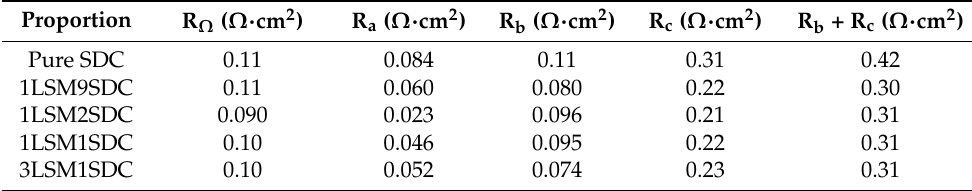
Figure 7. ( a ) EIS of the LSM-SDC (La 0.1 Sr 0.9 MnO 3 −δ -Ce 0.8 Sm 0.2 O 2 −δ ) composite series measured at 550 °C, OCV, fuel cell mode; points for experimental data, line for fitting data, ( b ) equivalent circuit. Table 1. Fitting results of EIS data in Figure 7a.